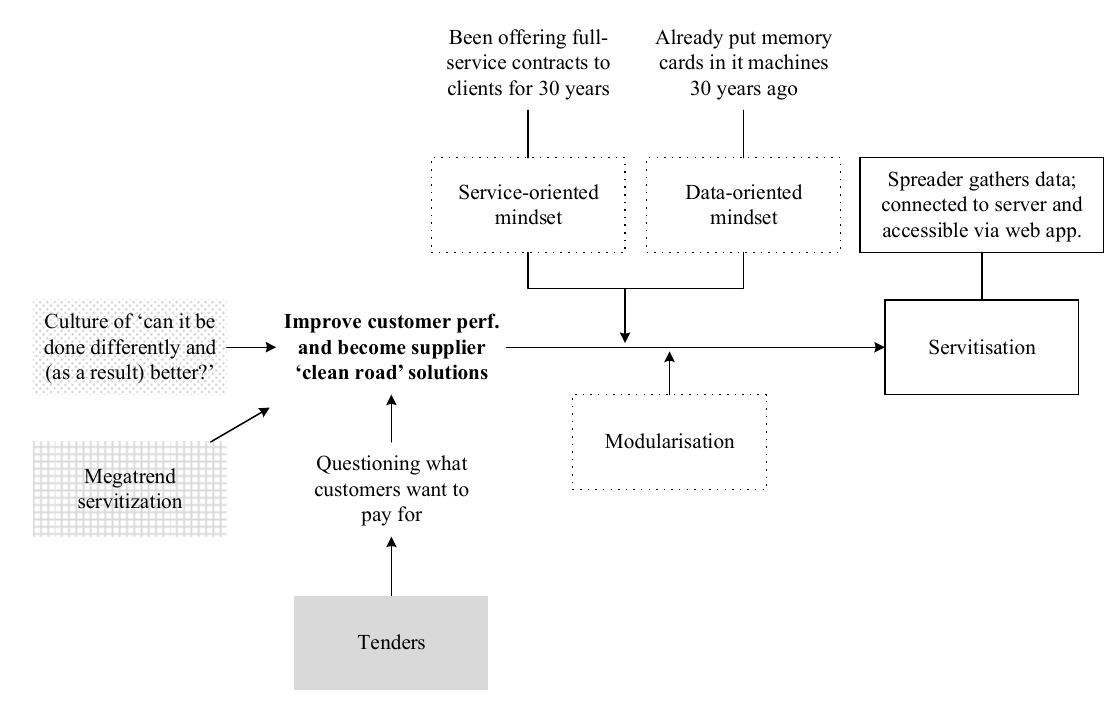
Figure A1. Flow chart for Aebi Schmidt. Adm. Sci. 2020 , 10 , 30